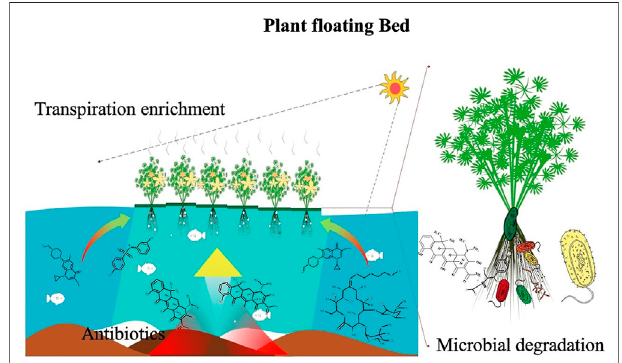
FIGURE 6 | Schematic diagram of plant fl oating bed adsorption of antibiotics. Plant roots adsorb antibiotics in the aquatic environment and sediment, and then antibiotics are degraded by microorganisms enriched by the